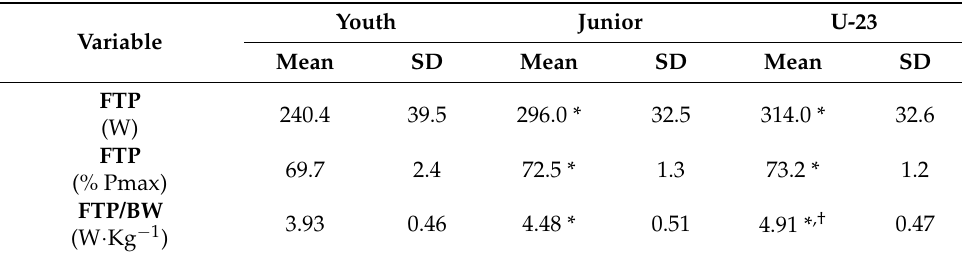
Table 5. Estimated functional threshold